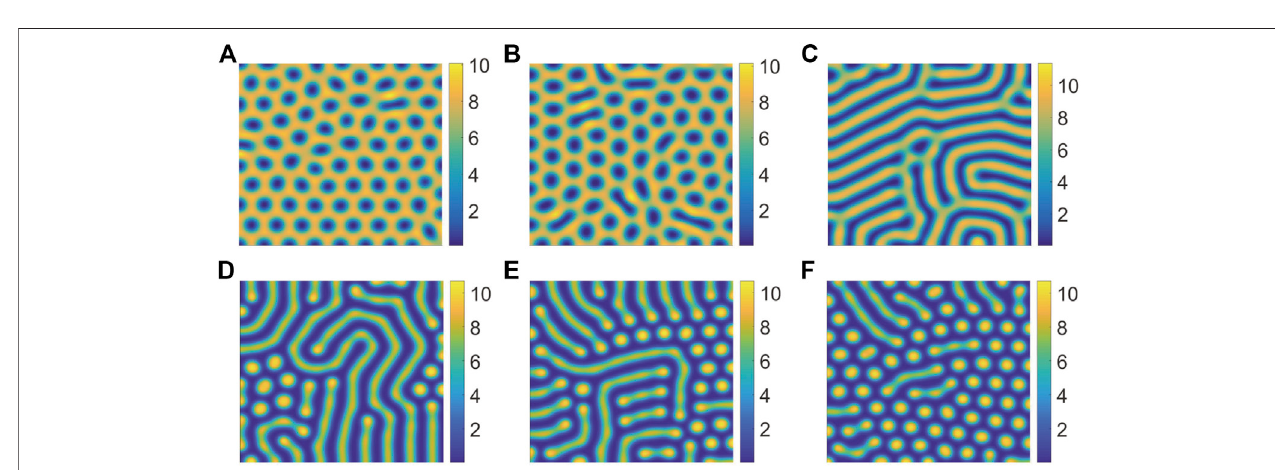
Frontiers in Physics |